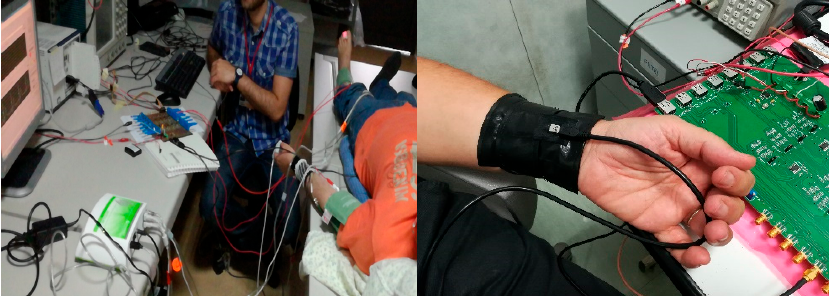
Figure 22. Some images of the validation setup used in our laboratories. In the first image we compare the processed PPG/ECG time-series with same ones obtained by commercial PPG/ECG medical device.